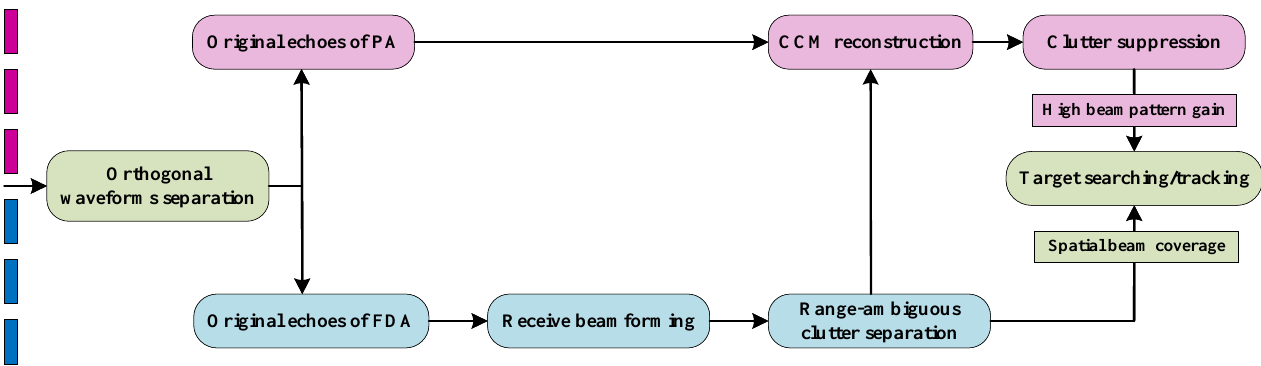
Figure 4. Procedure of moving target detection with the proposed PA-FDA dual-mode radar.